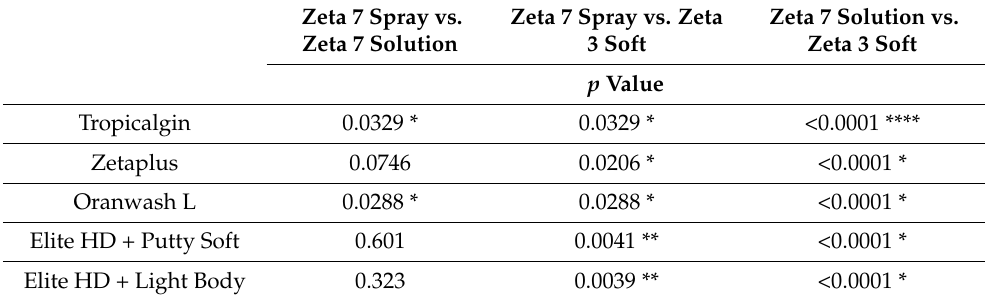
Table 6. The comparison of the results of the disinfection efficacy between the three used disinfectants. Zeta 7 Spray